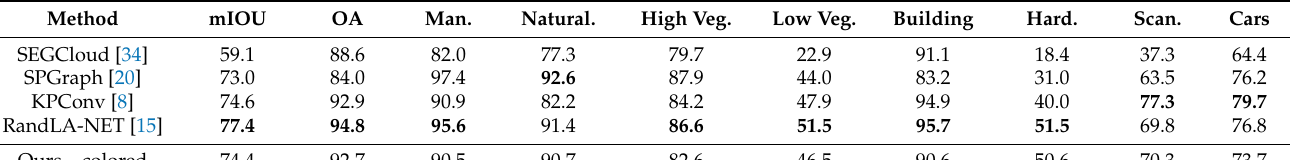
Table 3. Semantic segmentation results for reduced-8 data.